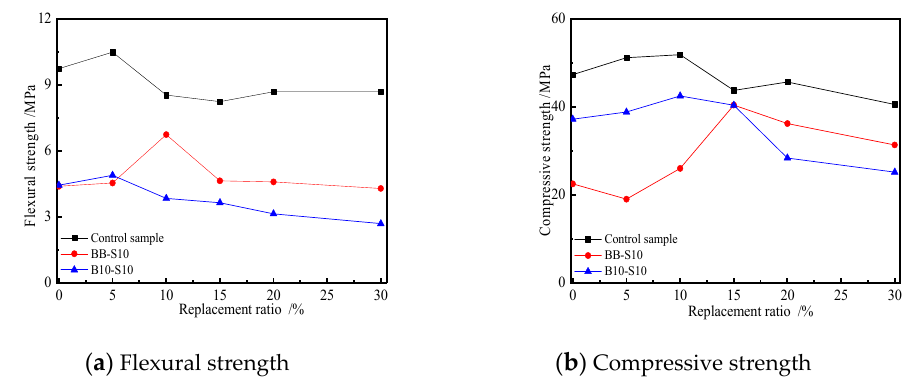
Figure 10. Variation curves of the compressive and flexural strength of mortar with the replacement of cement with slag.